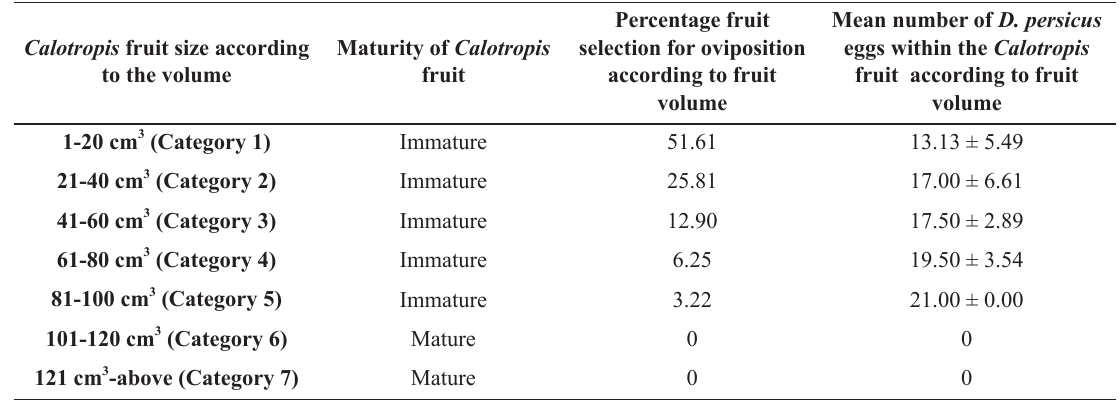
Table 2: Calotropis fruit size categories, maturity status of Calotropis fruit, percentage fruit selection for oviposition according to fruit volume and mean number of D. persicus eggs within the C alotropi s fruit according to fruit volume.